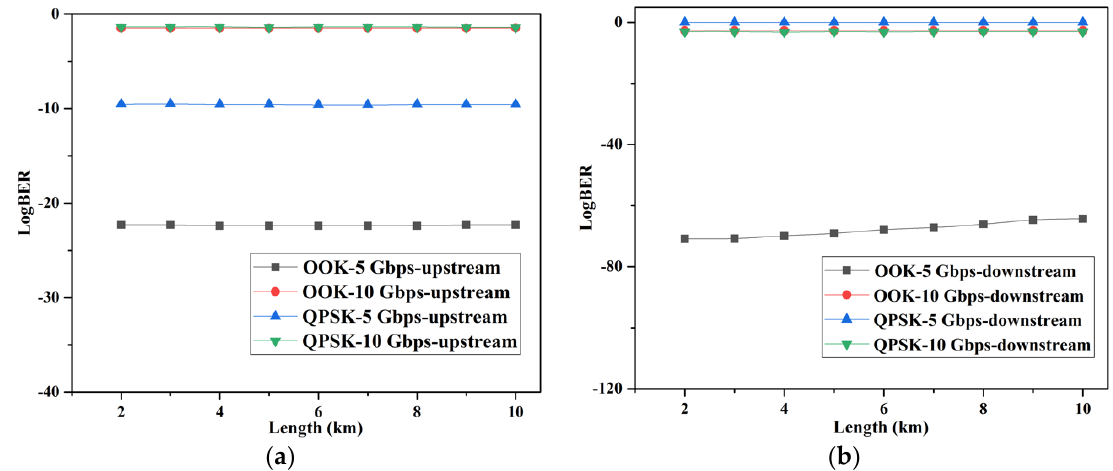
Figure 11. BER curves of the system on the OOK and QPSK modulation versus transmission dis- tance at ( a ) upstream link; ( b ) downstream link. at ( a ) upstream link; ( b ) downstream